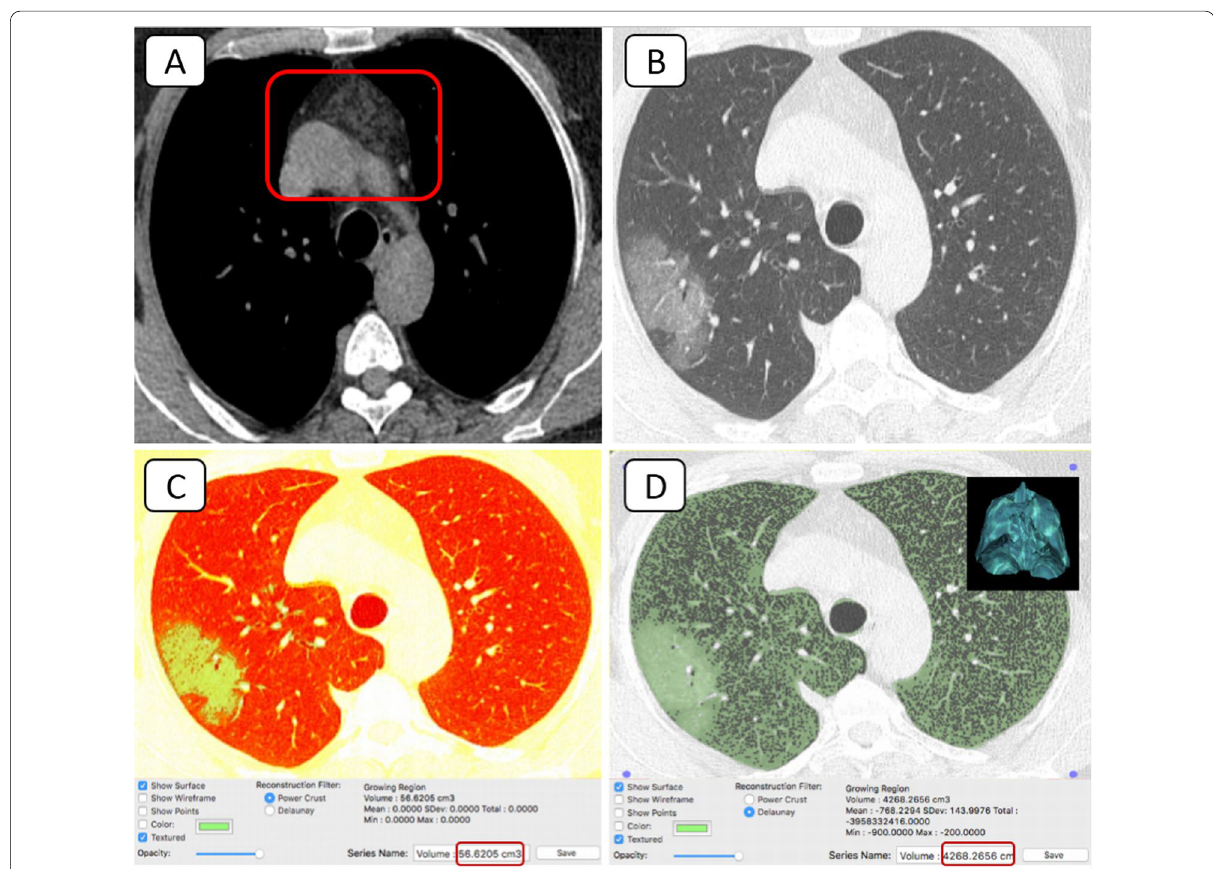
Fig. 6 A 48-year-old male COVID-19 patient complained of fever, dry cough, and chest pain: A Axial mediastinal window CT showed nodular infiltration of the thymic gland (grade 2) [red square]. B Axial lung window CT showed a right upper lobar sub-pleural ground-glass patch. C – D Axial 3D volumetry cuts highlighted the right sub-pleural ground-glass patch. The pathological lung volume was around 1.3% of the total